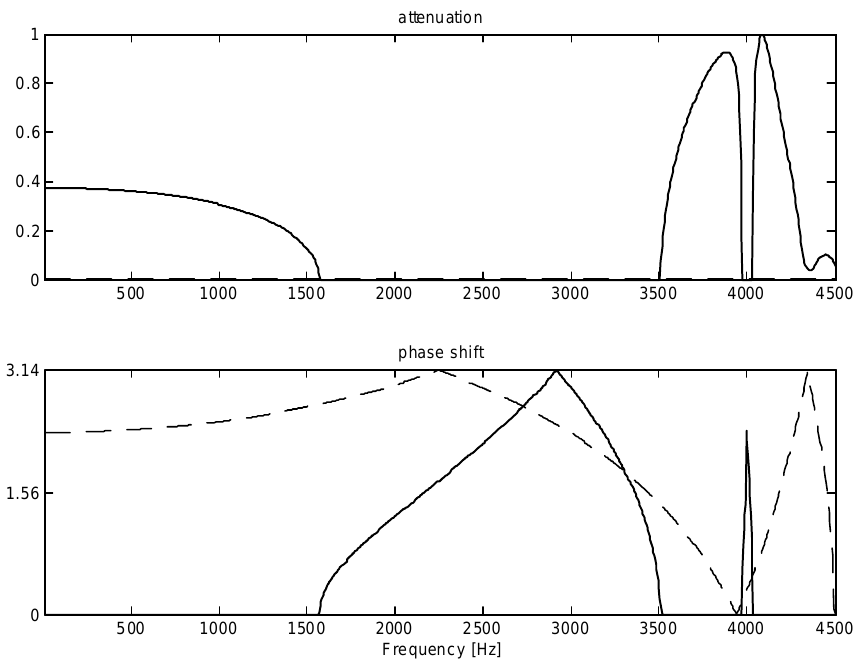
Fig. 12. Propagation characteristics of a periodic tapered shell type